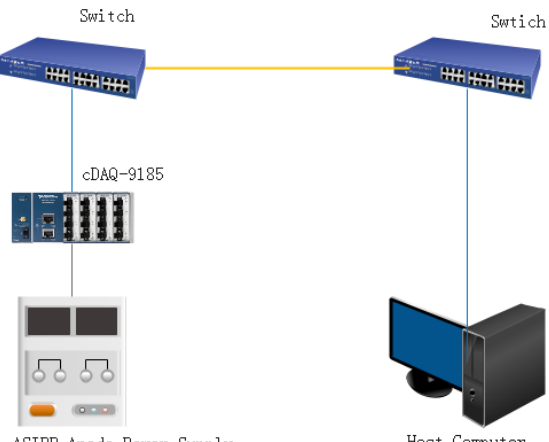
Table 3 . Comparison of reference voltage setting value, read value, and the actual output value of #1 anode power supply.